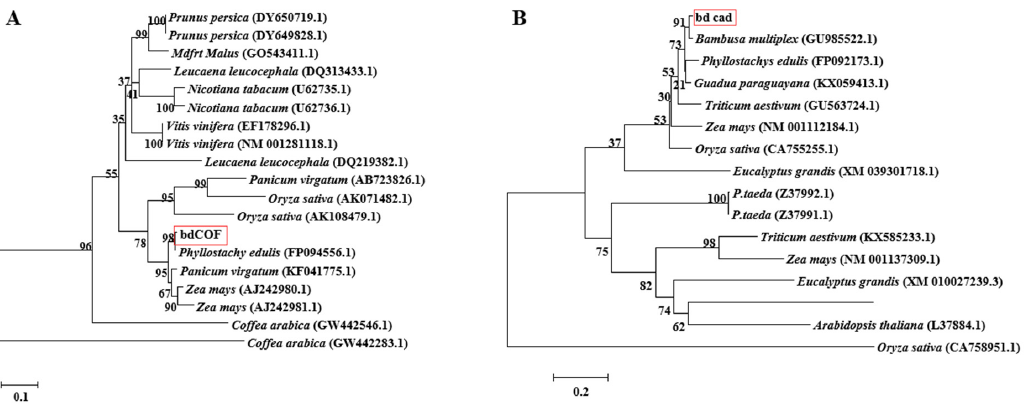
Figure 1. Target gene phylogenetic tree based on neighbor-joining algorithm. ( A ): CCoAOMT2 phylogenetic tree; ( B ): CAD5 phylogenetic tree. The red box highlights the gene of interest. The numbers above/below the nodes indicated bootstrap number.